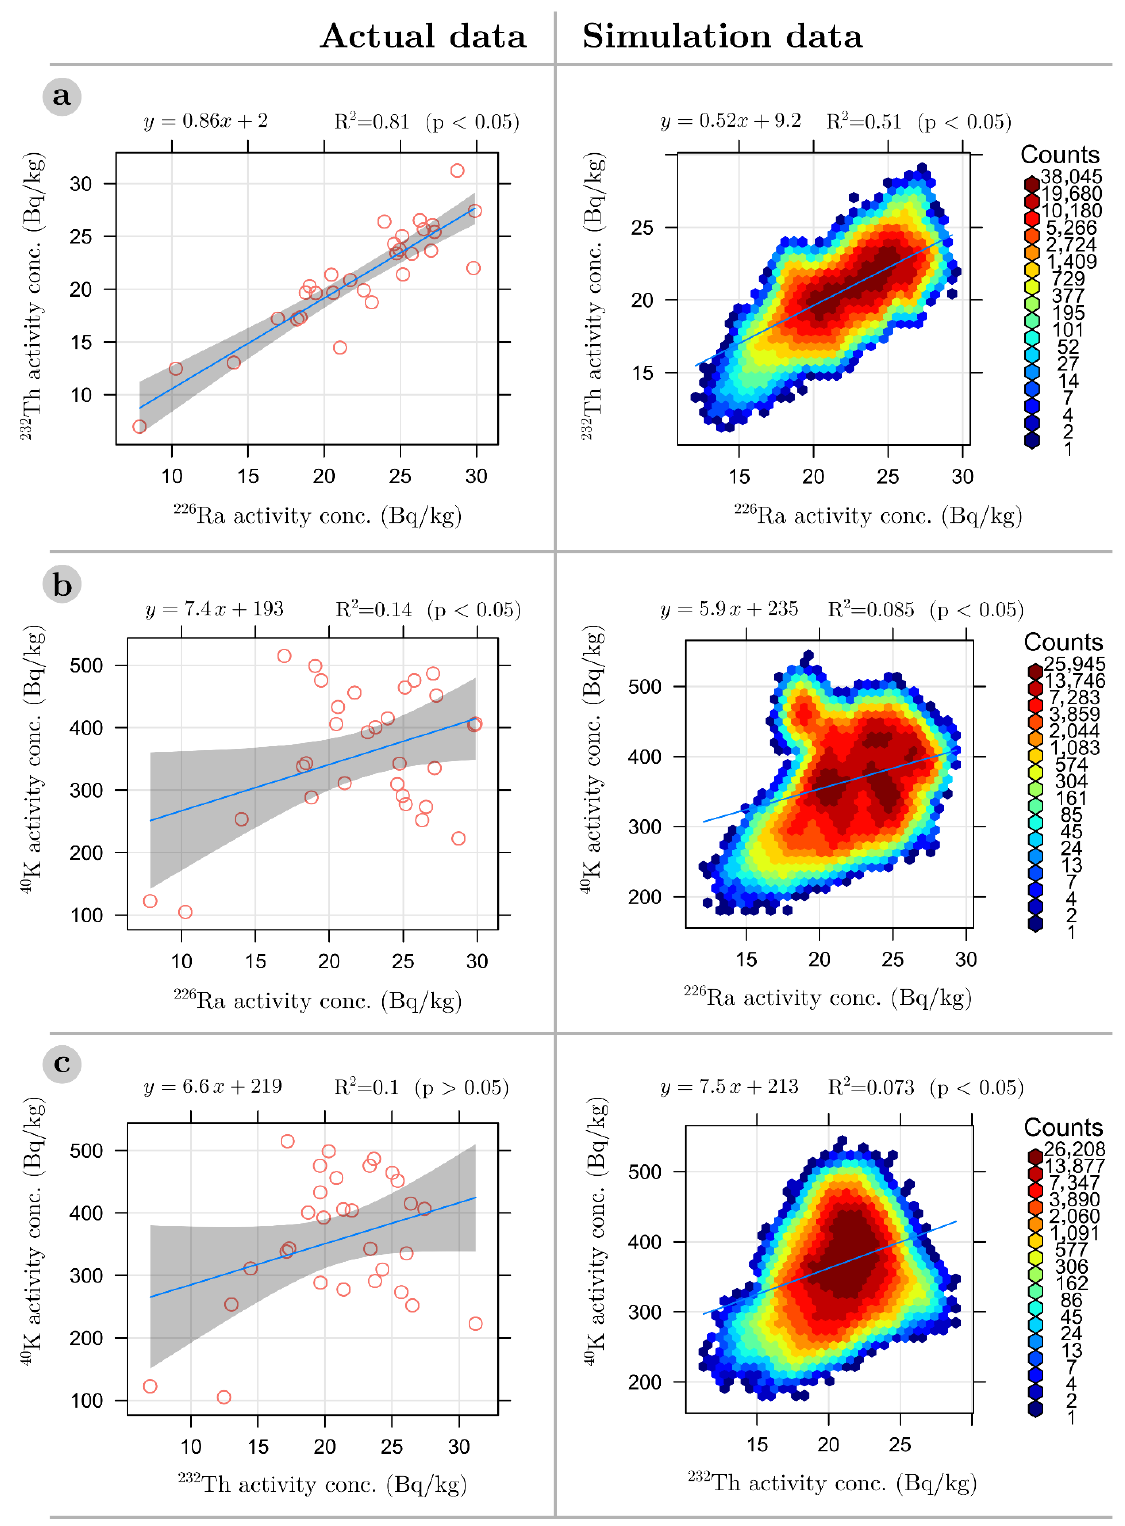
Figure 2. Correlation analysis of natural radioisotopes ( 226 Ra, 232 Th, 40 K) versus each other for actual and simulation data. ( a ) Correlation between 226 Ra and 232 Th activity concentration, ( b ) Correlation between 226 Ra and 40 K activity concentration, ( c ) Correlation between 232 Th and 40 K activity concentration.